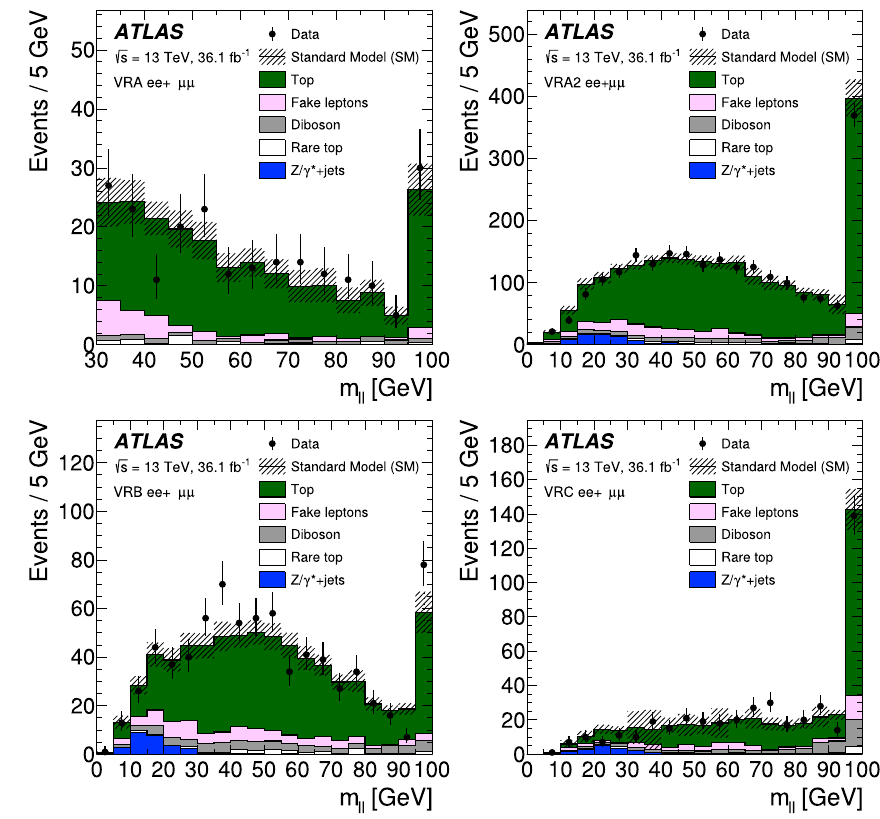
Fig. 5 Validation of the background modelling for the low- p T analysis in VRA (top left), VRA2 (top right), VRB (bottom left) and VRC (bottom right) in the SF channels. The t ¯ t and Wt backgrounds are normalised in e μ data samples for which the requirements are otherwise the same as in the VR in question. All uncertainties in the background expectation are included in the hatched band. The last bin always contains the